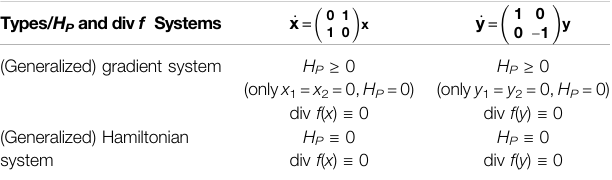
TABLE 1 | Two criteria on the planar linear saddle system with zero divergence.